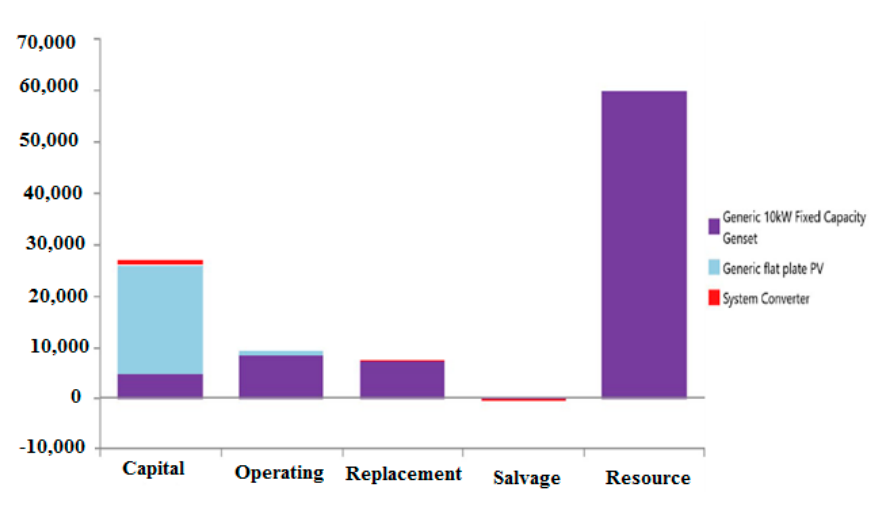
Figure 13. Cost summary of the system (1 kW PV).